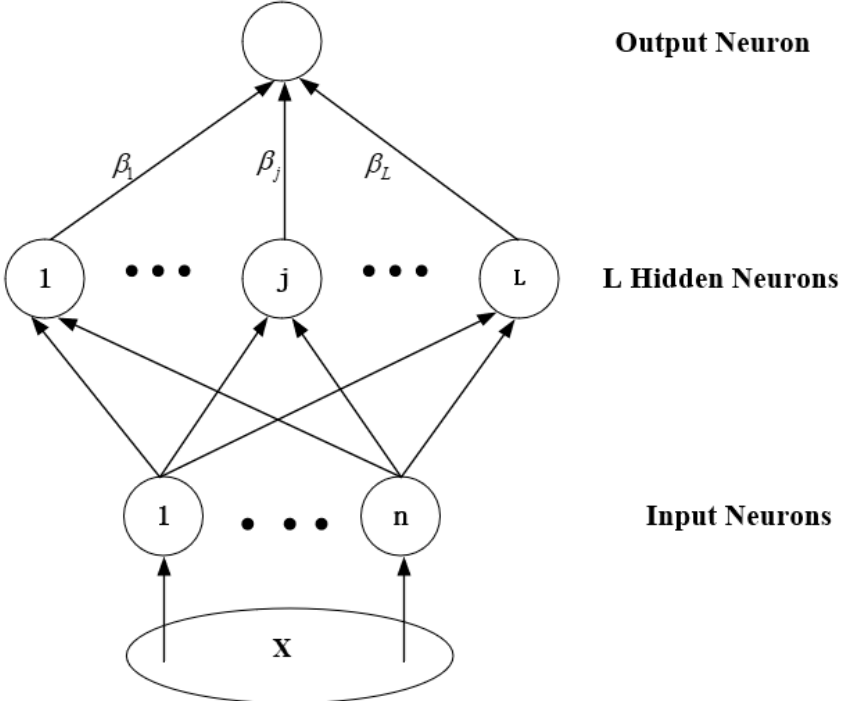
Figure 3. Structure of the designed ELM.